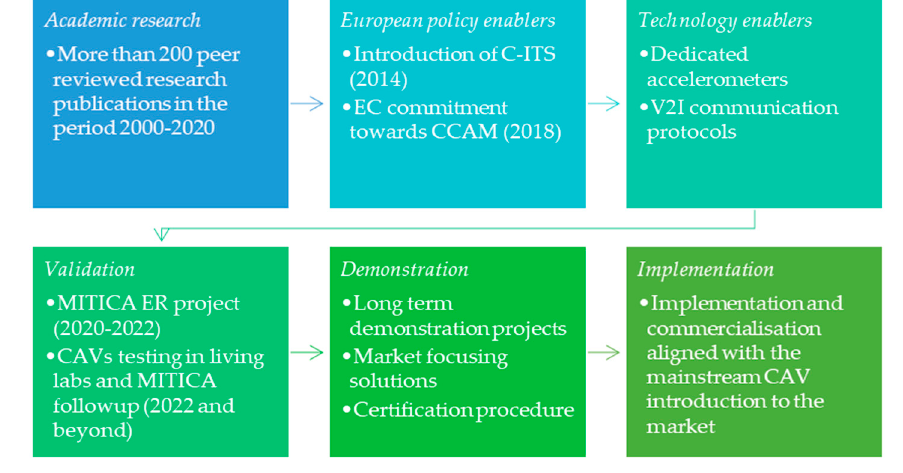
Figure 4. Pathway to validating iSHM with CAVs and steps beyond.